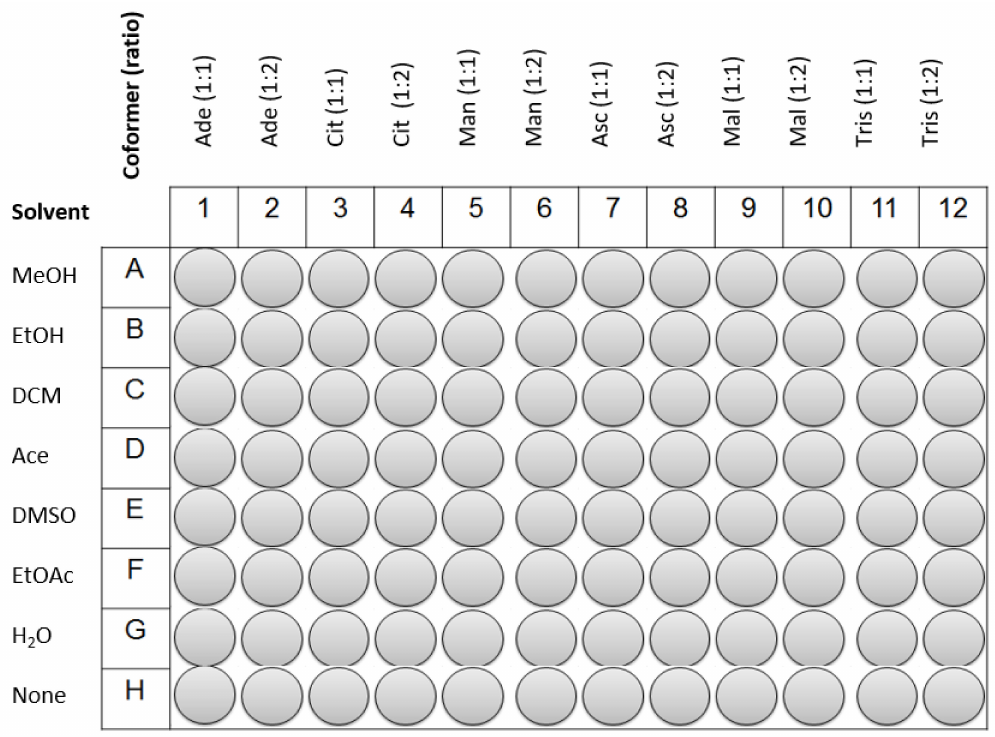
Figure 6. Coformers, ratio of drug:coformer and solvents used on the 96-well plate. The H line refers to the respective physical mixture